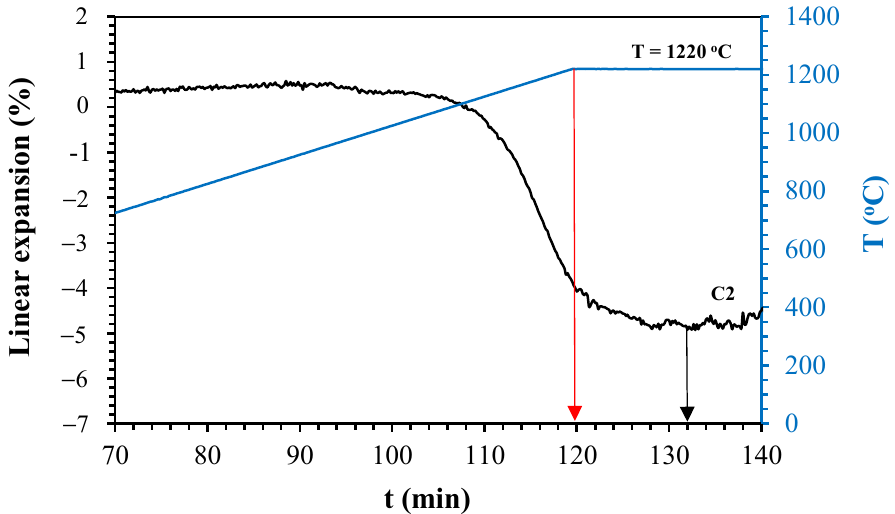
Figure 7. Linear expansion as a function of holding time of C2 at 1220 °C.